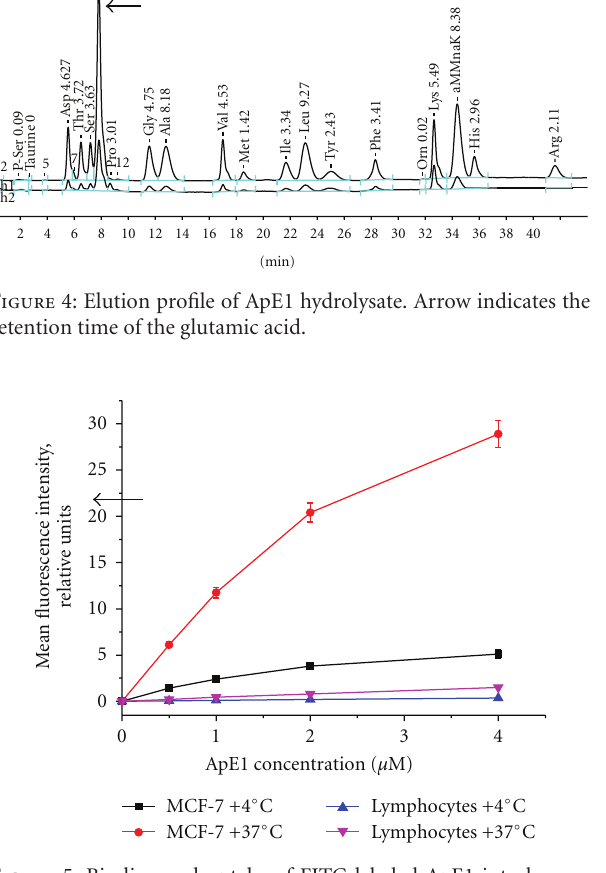
Figure 5: Binding and uptake of FITC-labeled ApE1 into human breast adenocarcinoma MCF-7 cells and peripheral blood lympho-